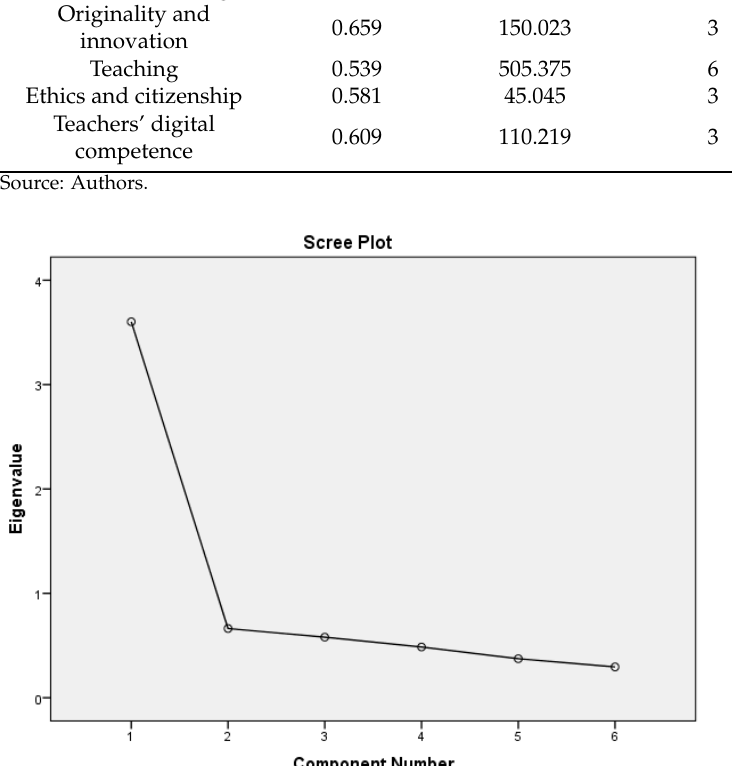
Figure 2. Sedimentation graph of the competence of Transformation of Society. Source: Authors.